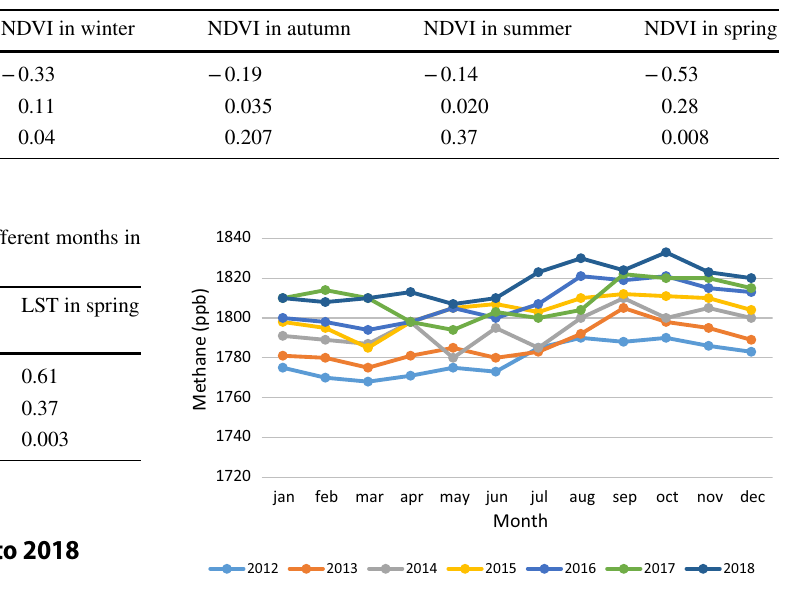
Fig. 2 Monthly change in methane from 2012 to